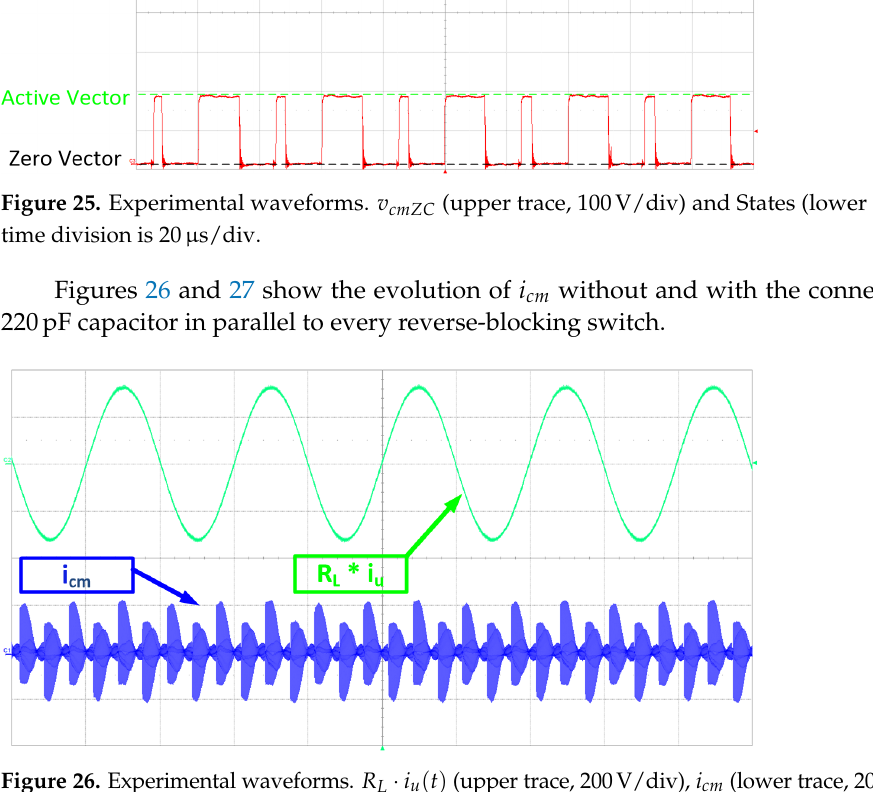
Figure 26. Experimental waveforms. R L · i u ( t ) (upper trace, 200V/div), i cm (lower trace, 200mA/div). The time division is